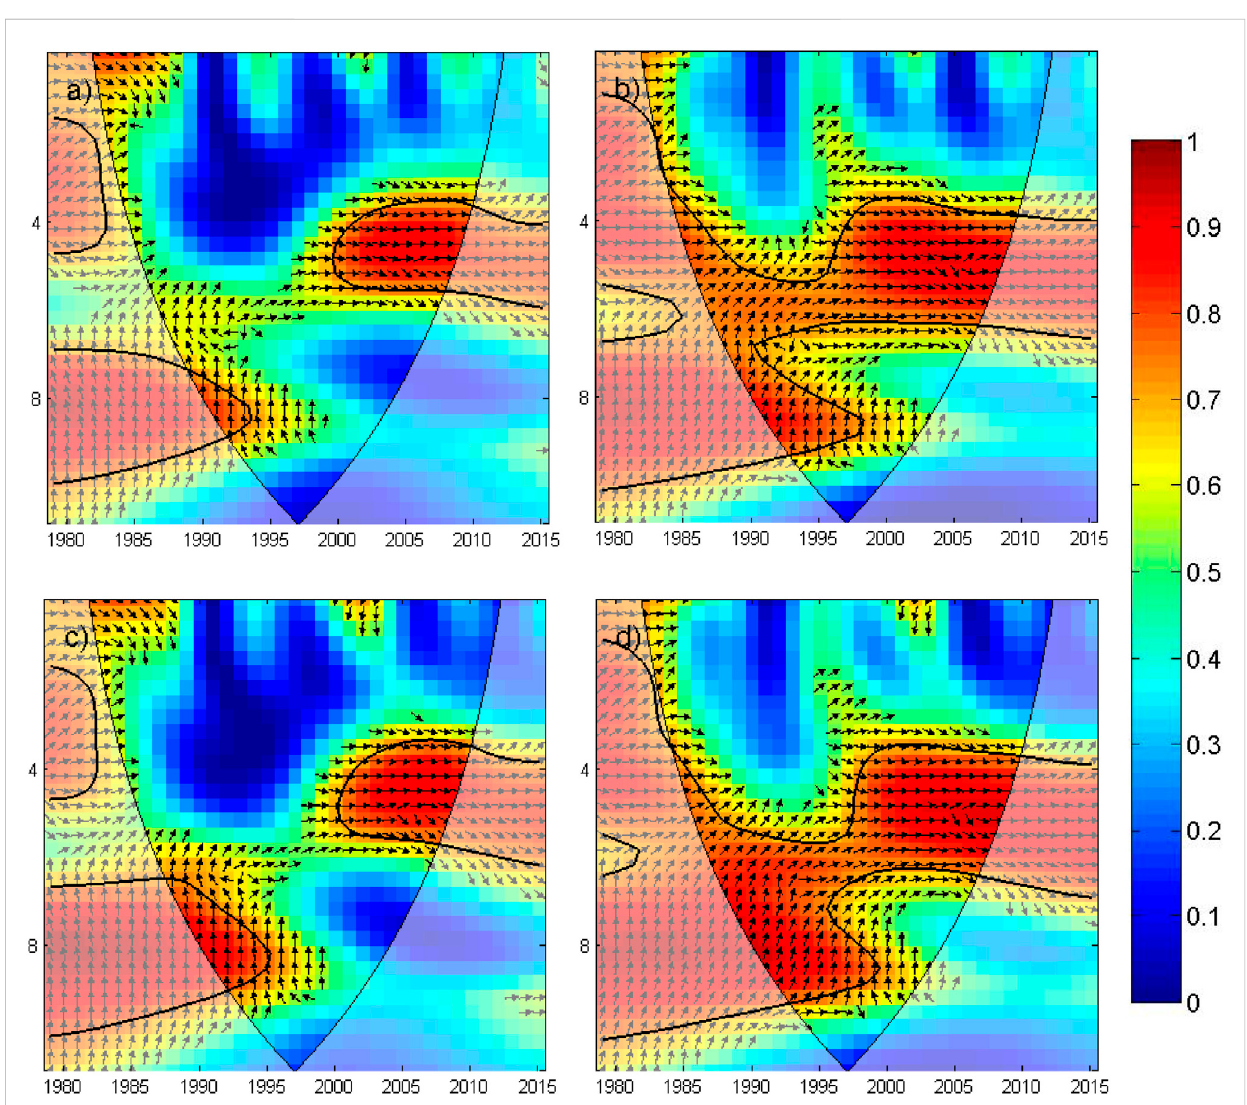
FIGURE 5 Wavelet coherent spectra of annual mean precipitation indices and WPSH over the MLYR from 1979 to 2015: (A) PRCPTOT and WPSH area, (B) R25 mm and WPSH area, (C) PRCPTOT and WPSH intensity, (D) R25 mm and WPSH intensity.